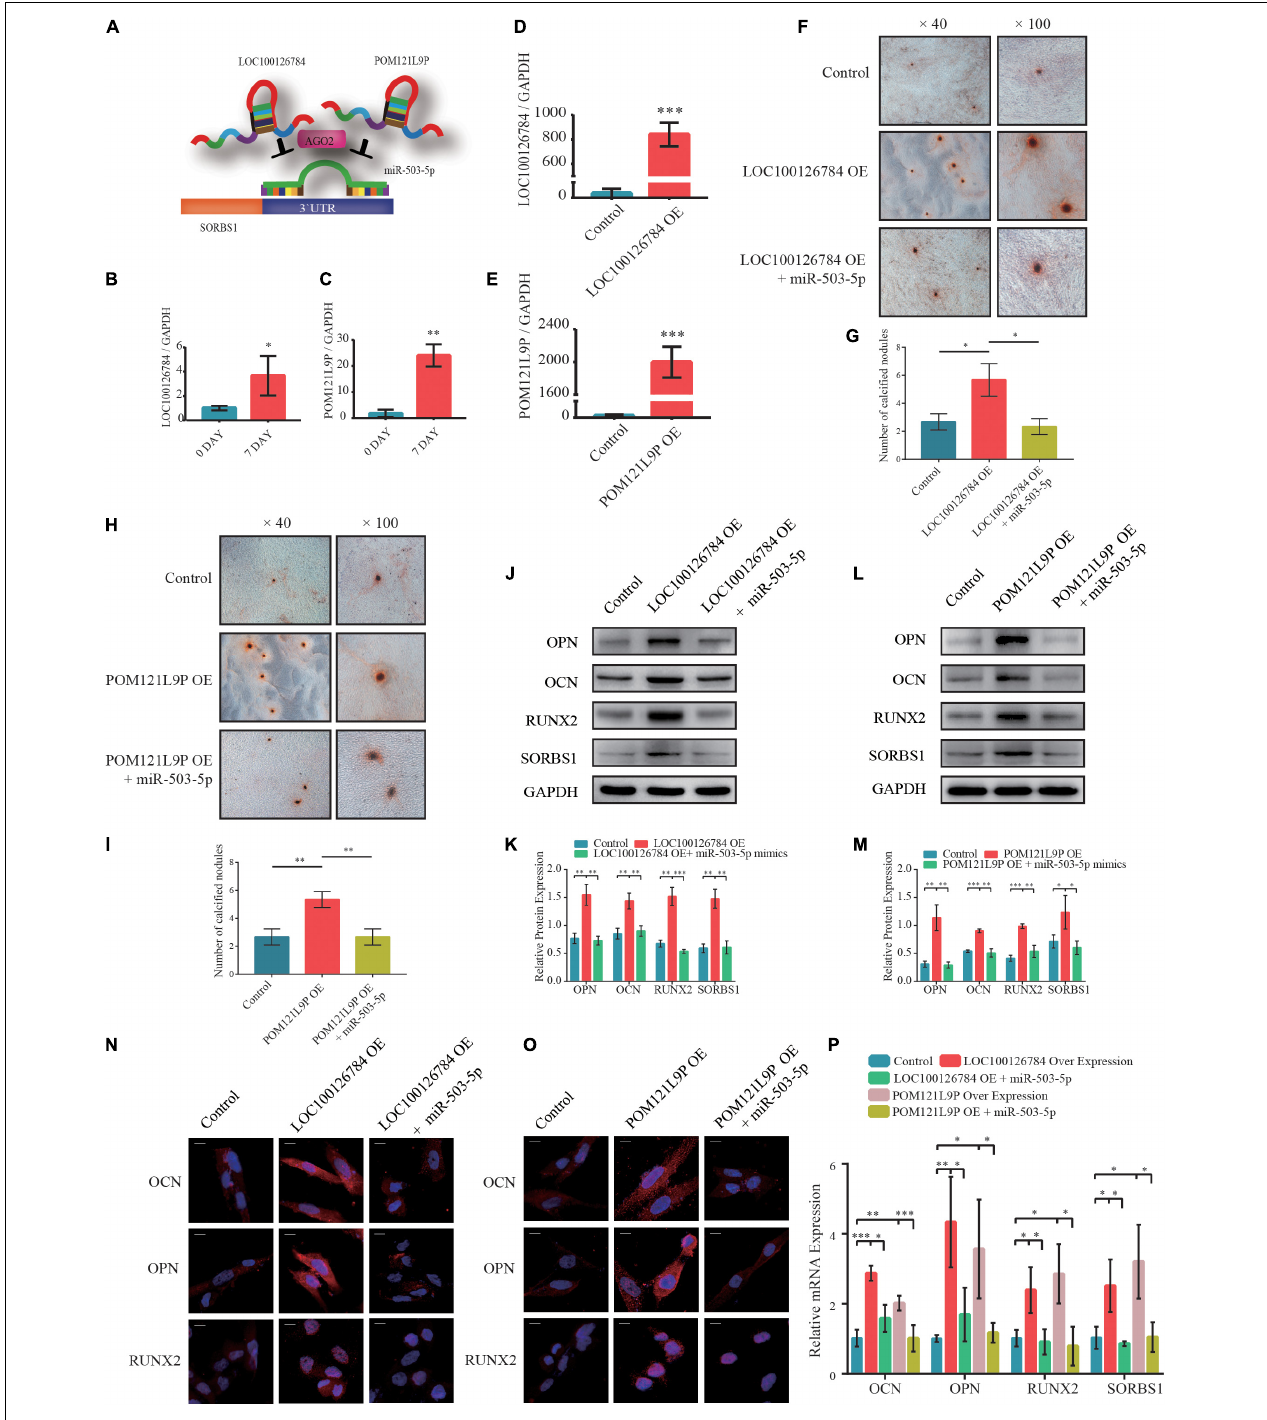
FIGURE 4 | LOC100126784 and POM121L9P promotes osteogenic differentiation in BMSCs by inhibiting miR-503-5p. (A) Schematic illustration of LOC100126784 and POM121L9P sponging of SORBS1-targeting miR-503-5p. (B,C) Verification of relative RNA expression levels of LOC100126784 and POM121L9P during early osteoblast differentiation of BMSCs. (D,E) BMSCs were transfected with lentiviral or empty vector and miRNA- or control-mimics. LOC100126784 and POM121L9P expression levels were measured using RT-qPCR. (F,H) On day 7 of osteogenic induction in BMSCs, slides were stained with Alizarin Red. Calcium node size and number were evaluated at × 40 and × 100 magnification. (G,I) Quantitative analysis of the number of calcium nodules in (F,H) . Expression levels of osteogenesis markers OCN, OPN, and RUNX2 and the targeted gene SORBS1 were detected via western blotting (J,L) , quantified protein expression by densitometric analysis (K,M) , immunofluorescence (IF) (N,O) , and RT-qPCR (P) . GAPDH served as an endogenous control. Quantitative data are presented as mean ± SD of three independent experiments; ∗ p < 0.05, ∗∗ p < 0.01, ∗∗∗ p < 0.001.